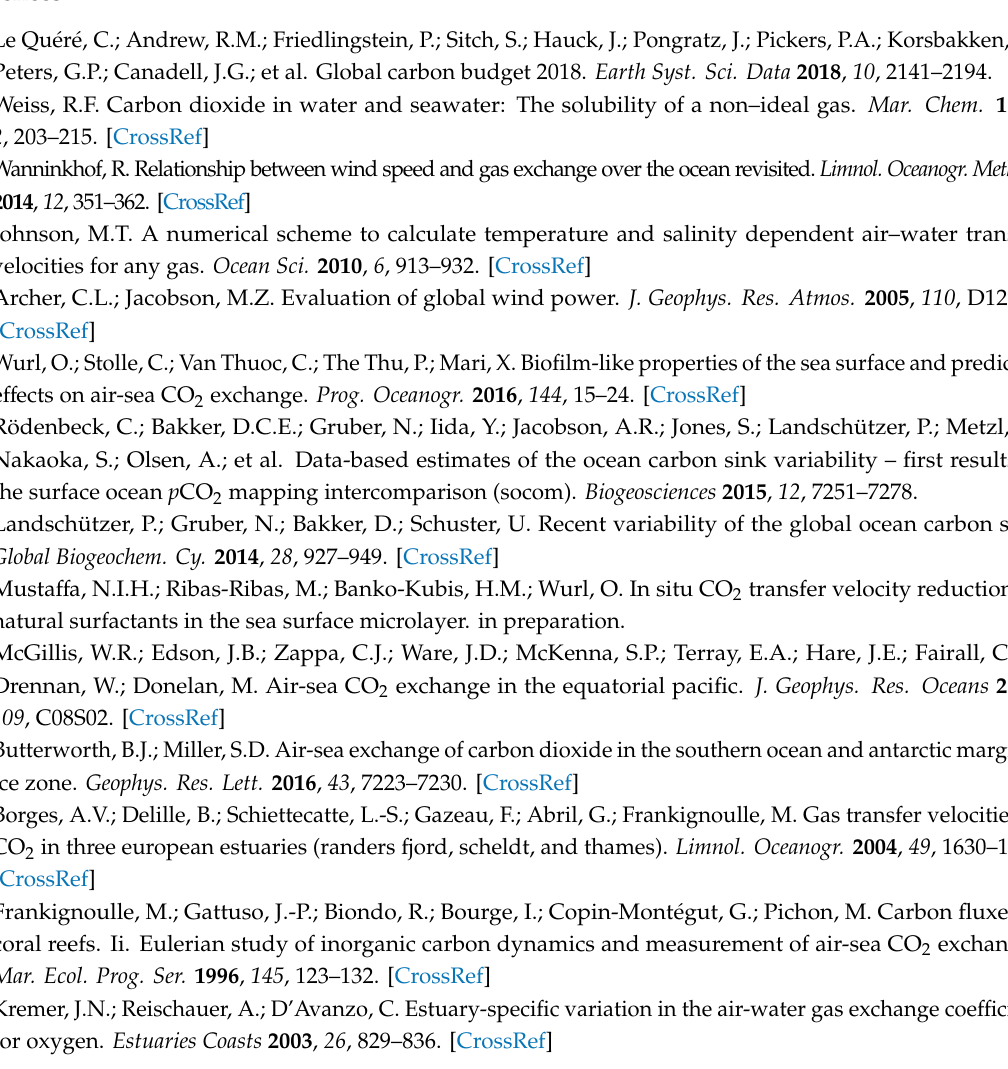
Figure S1: Fluxes calculated from the p CO 2 -based product for the period 1982–2018. (a) Global and from (b) to (f) where higher changes are expected: (b) Southern Ocean, (c) North Atlantic, (d) Tropical, (e) South Atlantic, and (f) South Pacific. Di ff erent colors represent di ff erent parameterizations, as in Figure 5: black indicates F W , blue indicates F K, orange indicates F K + I , rose indicates F W + I , and green indicates F M . The color legend is the same as in Figure 6 of the main